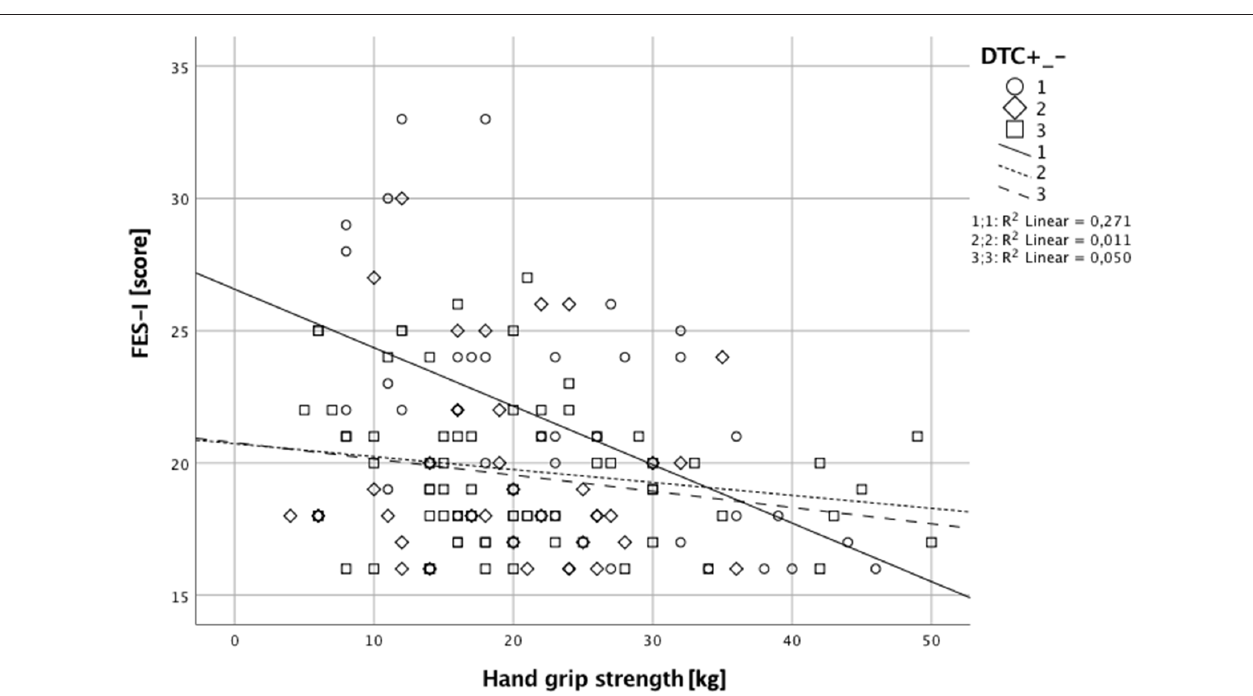
FIGURE 1 | This image shows the interaction of Falls Efficacy Scale International (FES-I) and hand grip strength. Negative dual task (DT) performers showed higher concerns of falling (CoF) and greater hand grip strength. Positive DT performers had reduced hand grip strength and less CoF. Scores of FES-I and a hand grip strength for non-uniform performers were between the scores of the two other